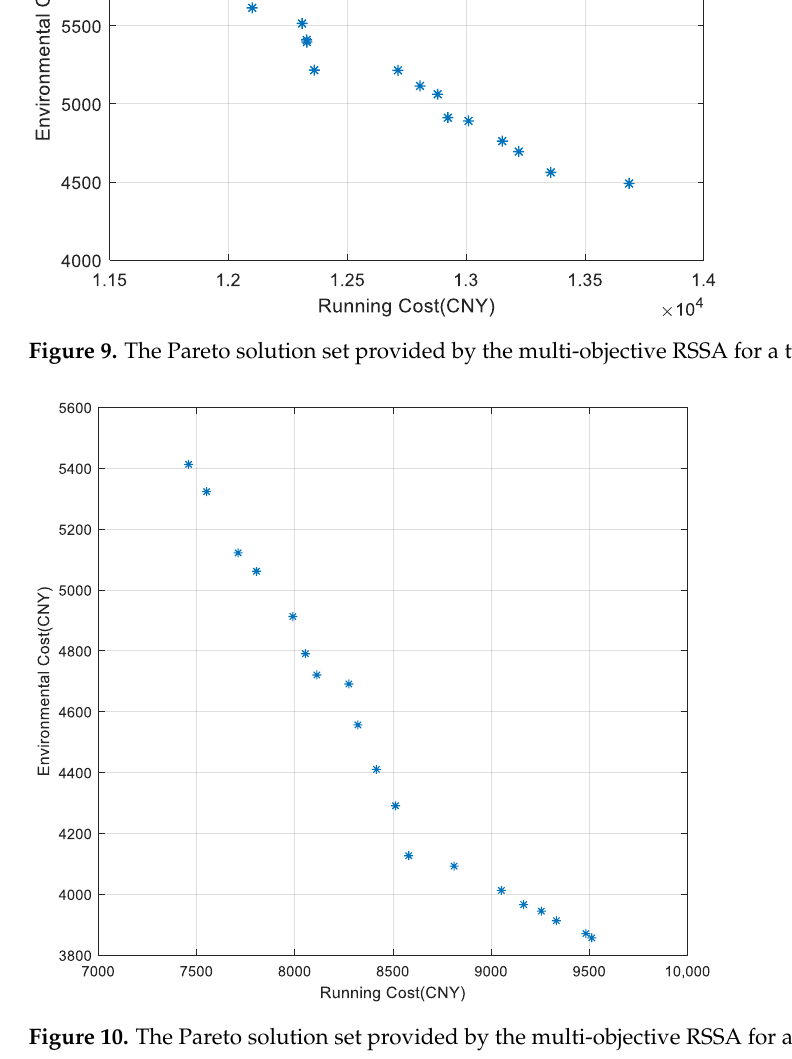
Figure 10. The Pareto solution set provided by the multi-objective RSSA for a typical day in winter.